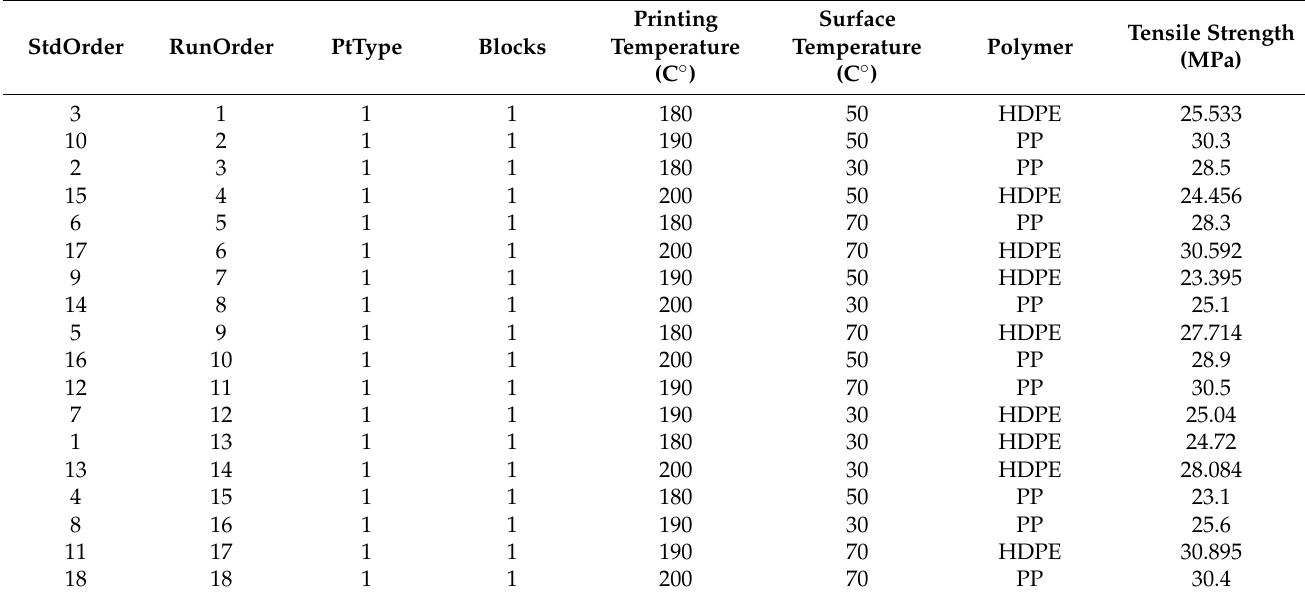
Table 4. Tensile strength for ANOVA